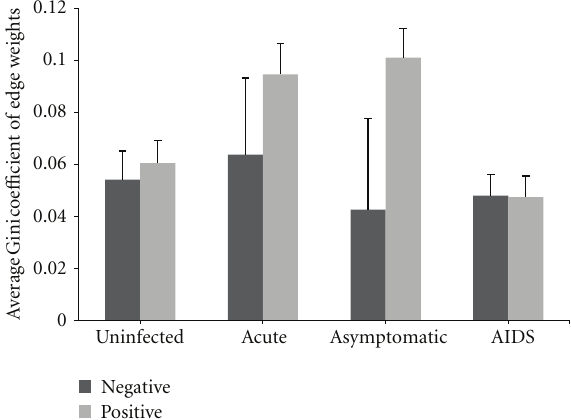
Figure 3: Average Gini coe ffi cient of positive and negative edge weights for genes in GCNs. “Negative” and “Positive” represent the negative and positive edge weights, respectively.